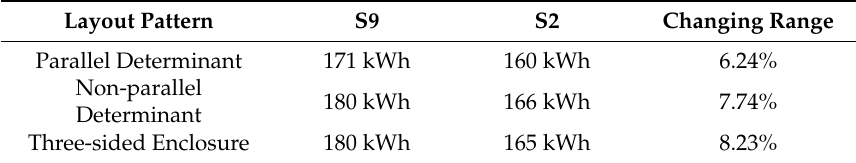
Table 1. Changing range of south